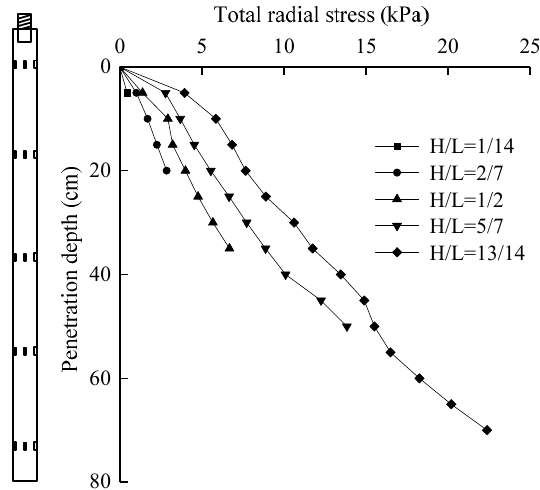
Figure 14. Relationship curve between total radial stress and penetration depth.